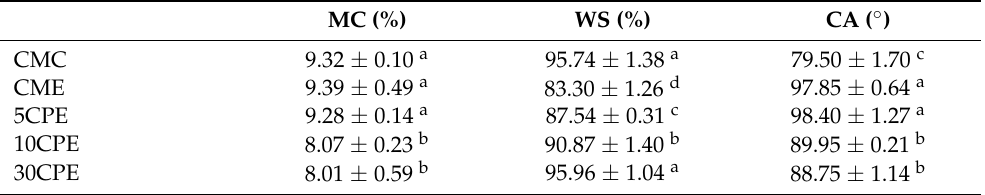
Figure 5. Mechanical properties of films. Tensile stress versus strain curve ( A ), and tensile strength and elongation at break ( B ) of films. Values represent mean ± SD ( n = 3), and different superscripts denote significant differences (DMRT, p < 0.05). Table 4. Moisture content, water solubility, and contact angle of